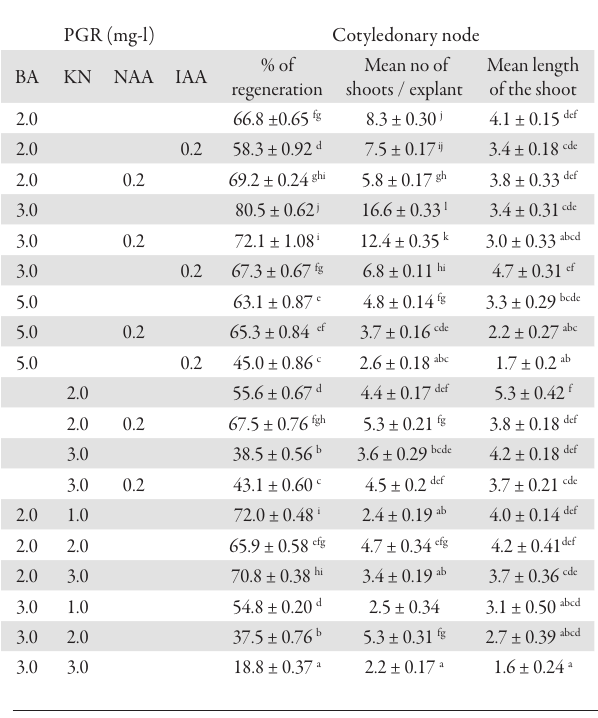
Tab. 1. Effect of plant growth regulators on shoot